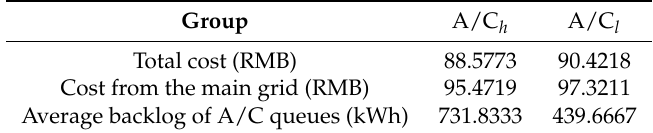
Table 5. Cost comparison of A/C h (higher deferrable degree) and A/C l (lower deferrable